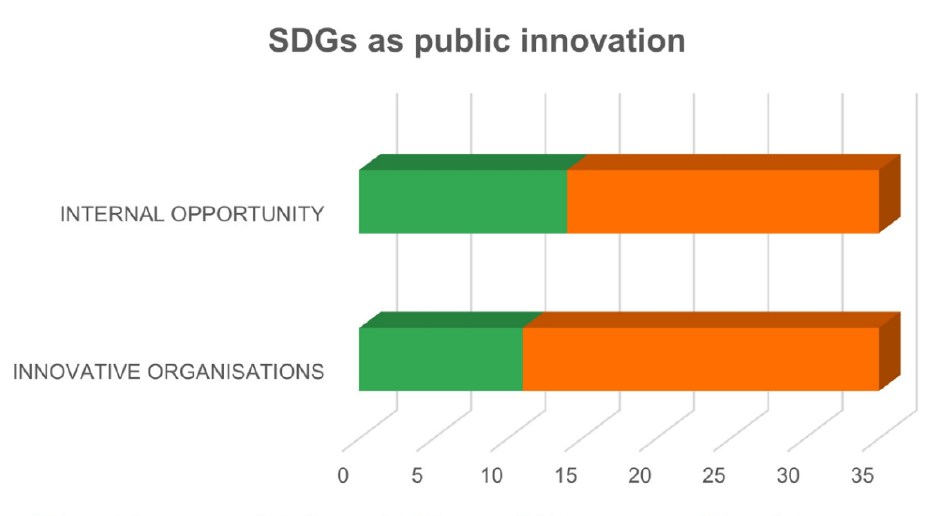
Figure 4. SDGs as public innovation.